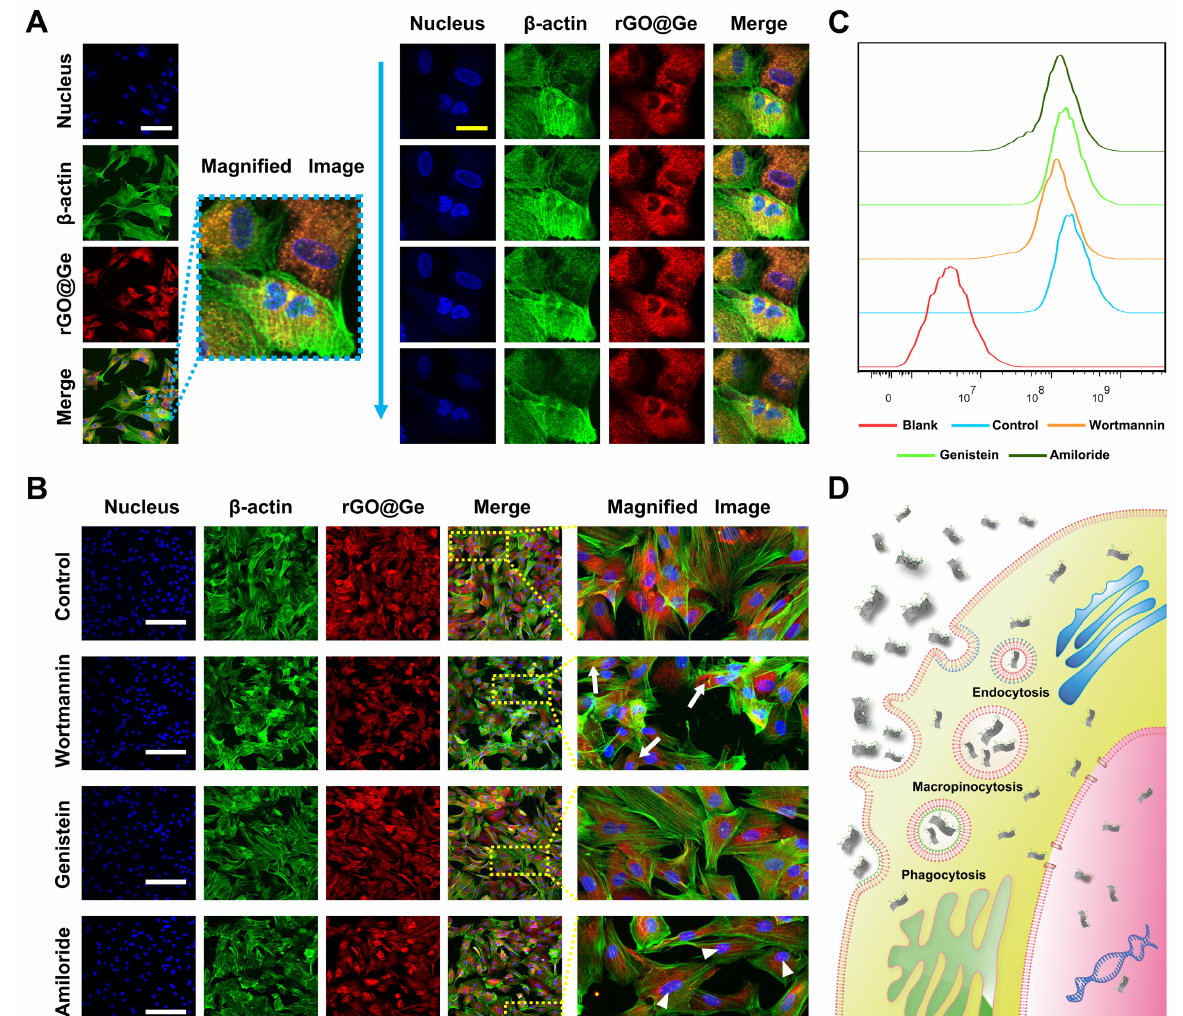
Figure 4. The entry pathway of rGO@Ge in ADSCs. ( A ) The Rhodamine 6G (R6G)-labeled rGO@Ge was taken up by ADSCs and it was located in the cytoplasm and nucleus; the right part shows the different images via the vertical Z axis, white bar: 100 µ m, yellow bar: 25 µ m. ( B ) The changes of the rGO@Ge taken up by ADSCs that were pretreated with different inhibitors. The arrow indicates the vacuole due to the blocky of the phagocytosis by wortmannin, and the arrowhead indicates the accumulation of rGO@Ge in the nucleus due to the inhibition of macropinocytosis by amiloride, bar: 200 µ m. ( C ) The flow cytometry analysis on the quantity variance of the R6G-labeled rGO@Ge that were taken up by ADSCs between the different inhibitor-pretreated groups. ( D ) Schematic diagram illustrating the pathway of rGO@Ge entering ADSCs and its distributions in cell.